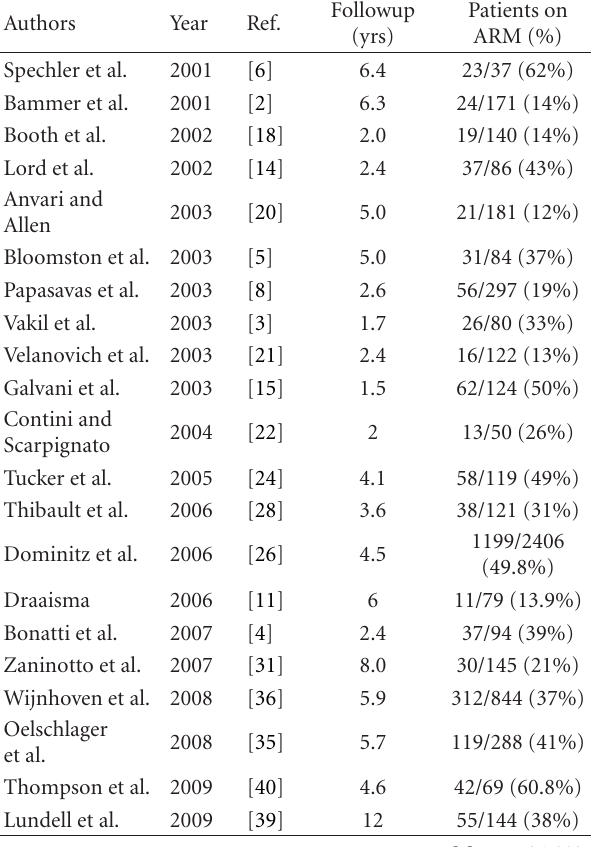
Table 3: Incidence of ARM use after